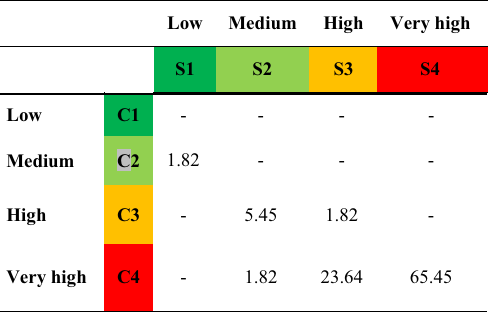
Fig. 12 a US salinity diagram; b Wilcox diagram for 55 water samples Table 10 Categorization of groundwater based on US salinity dia- gram for 55 water samples